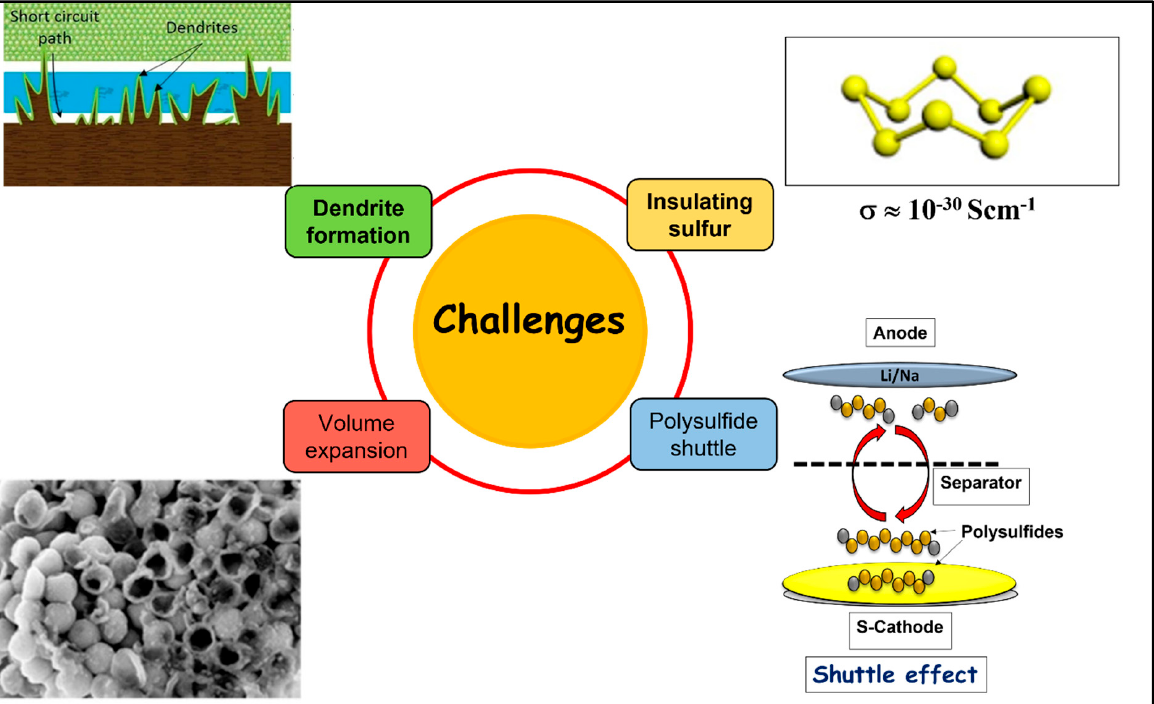
Figure 4. Schematic representation of challenges in metal (Li/Na)–sulfur batteries. (Reprinted with permission from [81]; Copyright 2019, 2018, Springer Singapore , 2018.)